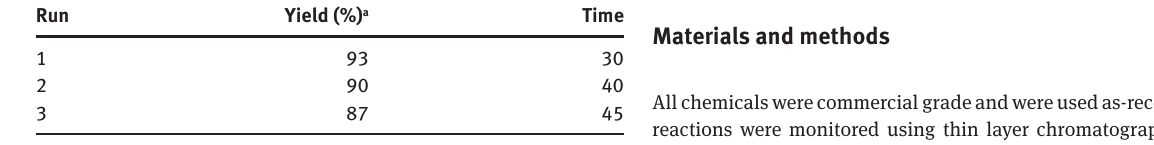
Table 5: The comparative study of the activity of FSM-16-SO